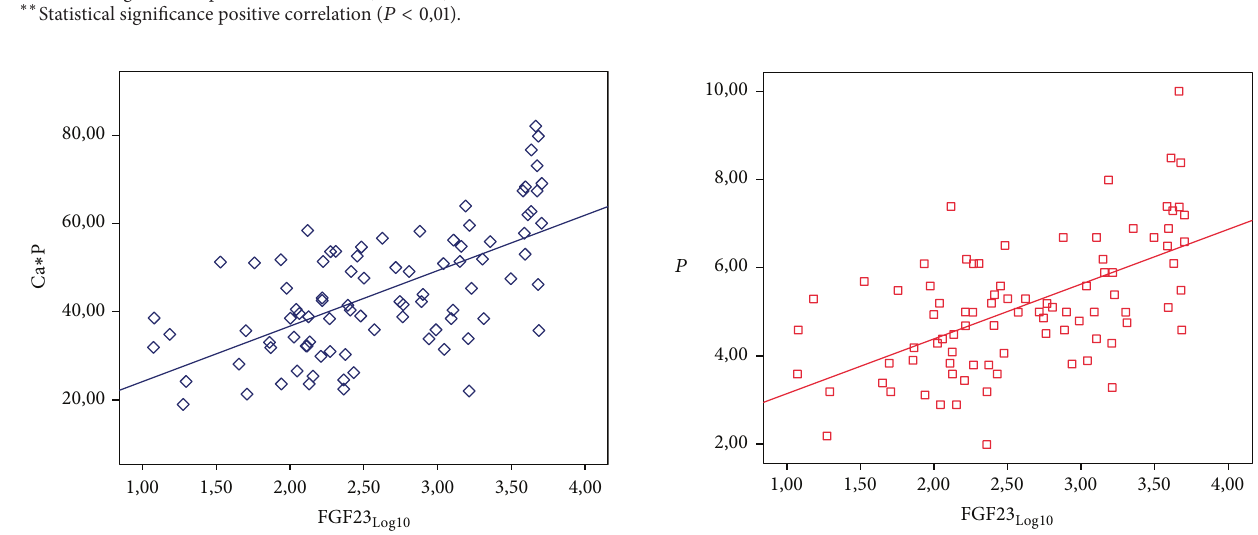
Figure 2: Relationship between FGF-23 and Ca ∗ P values. Figure 3: Relationship between FGF-23 and 𝑃